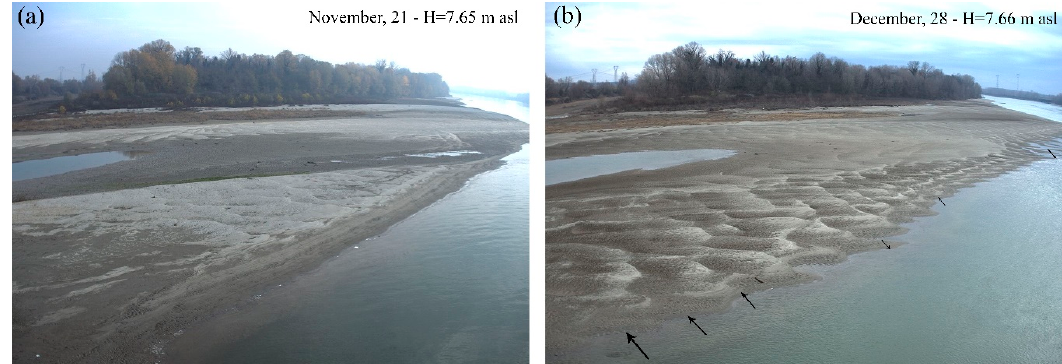
Figure 6. Images captured ( a ) before and ( b ) after the flooding event of December 13. The water levels are almost the same: on November 21 ( a ) it was 7.65 m a.s.l., while on December 28 ( b ) was 7.66 m a.s.l. The arrows indicate the displacement of the edge-of-water line.